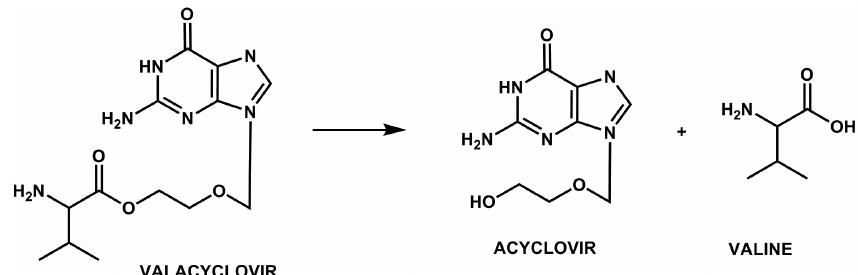
FIGURE 14 - Reaction illustrating the release of acyclovir from its prodrug.